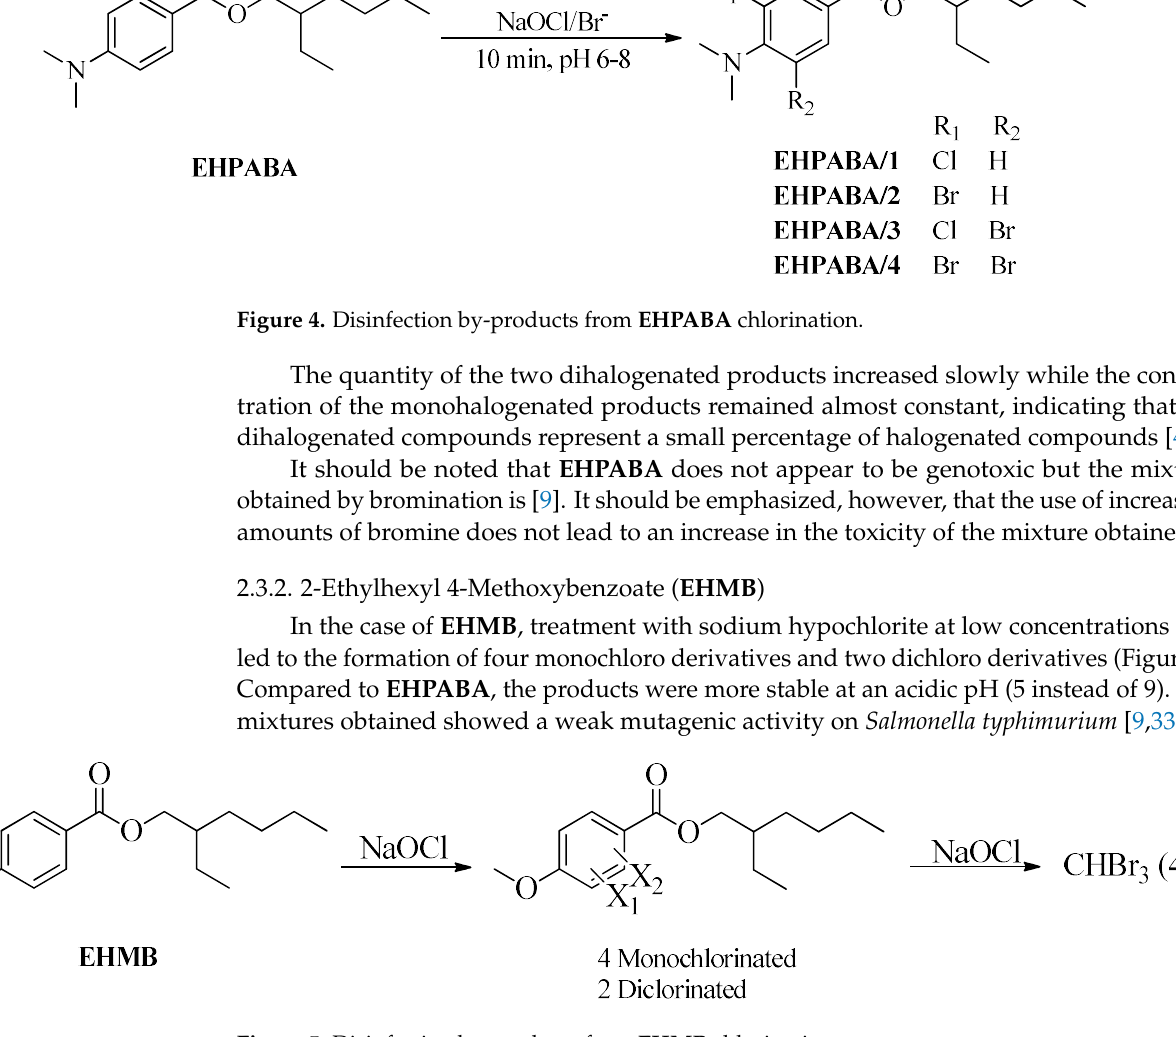
Figure 5. Disinfection by-products from EHMB